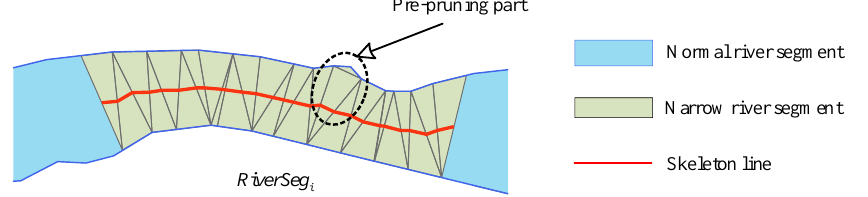
Figure 6. Calculation of the river segment length.